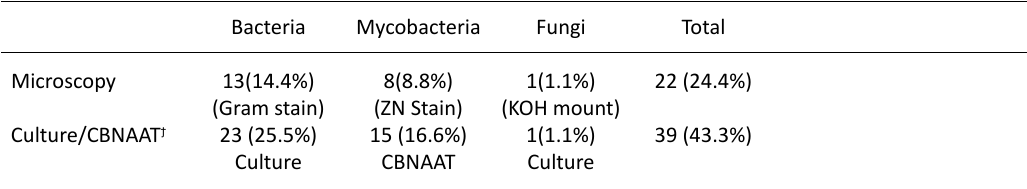
table 3. Distribution pattern of microorganisms on microscopy and culture from BAL fluid (n=90) Total recovery = 39(43.3%)